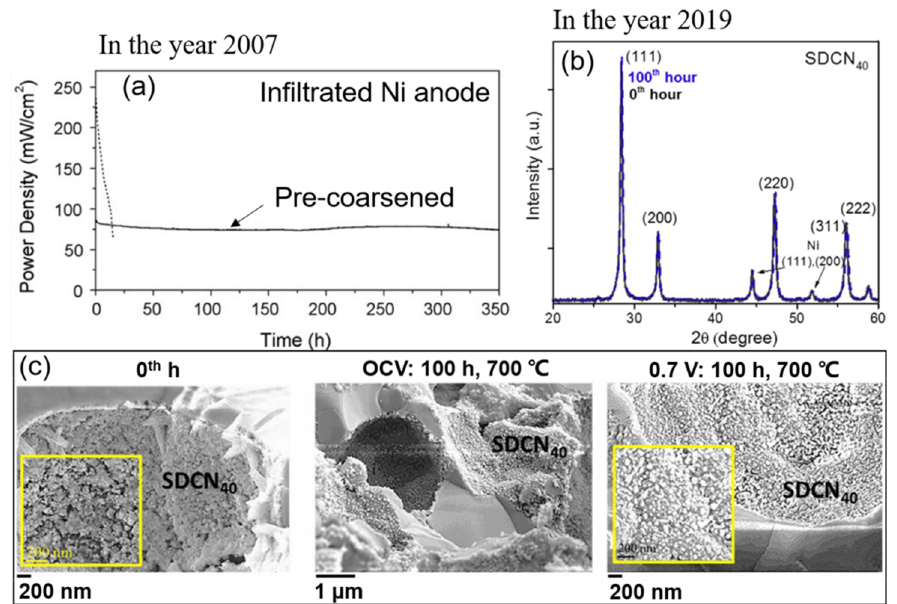
Figure 5. ( a ) Operation of tubular metal-supported SOFCs at 700 ◦ C with moist hydrogen fuel and oxygen as oxidant. Dashed line: as-infiltrated Ni anode, 300 m Acm − 2 ; solid line: Ni anode was pre- coarsened at 800 ◦ C, 100 mA cm − 2 , reproduced with permission from Ref. [23]. ( b ) X-ray diffraction patterns for SDCN 40 anode catalyst upon reduction at 700 ◦ C for 1 h (black) and after 100 h of thermal annealing at 700 ◦ C in 3% humidified hydrogen (blue). ( c ) SDCN40 catalyst anode via thermal annealing at 700 ◦ C and continuous electrochemical operation at 0.7 V for 100 h (corresponding to ( b )). ( b , c ) are reproduced with permission from Ref.